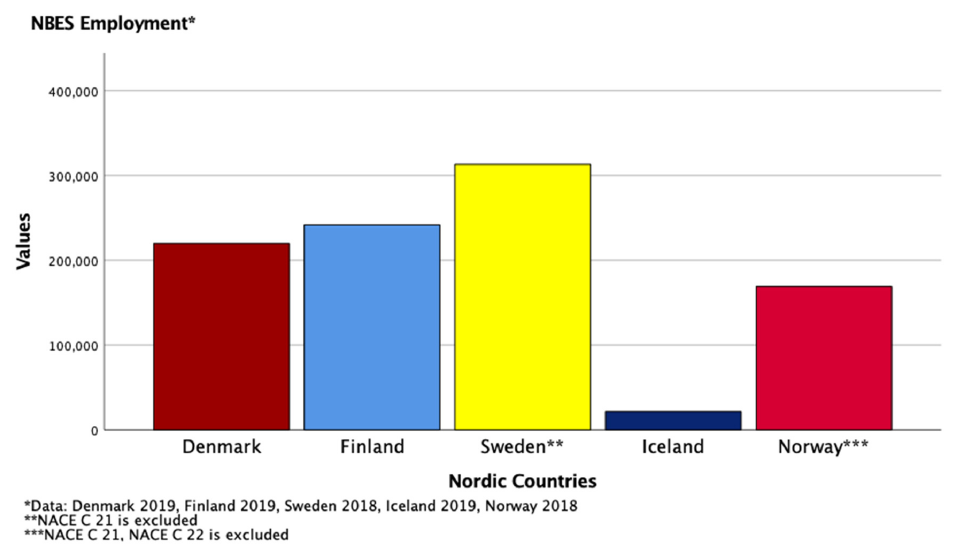
Figure 3. Nordic Bioeconomy Sectors (NBES) employment by country (Data: Eurostat 2021c).